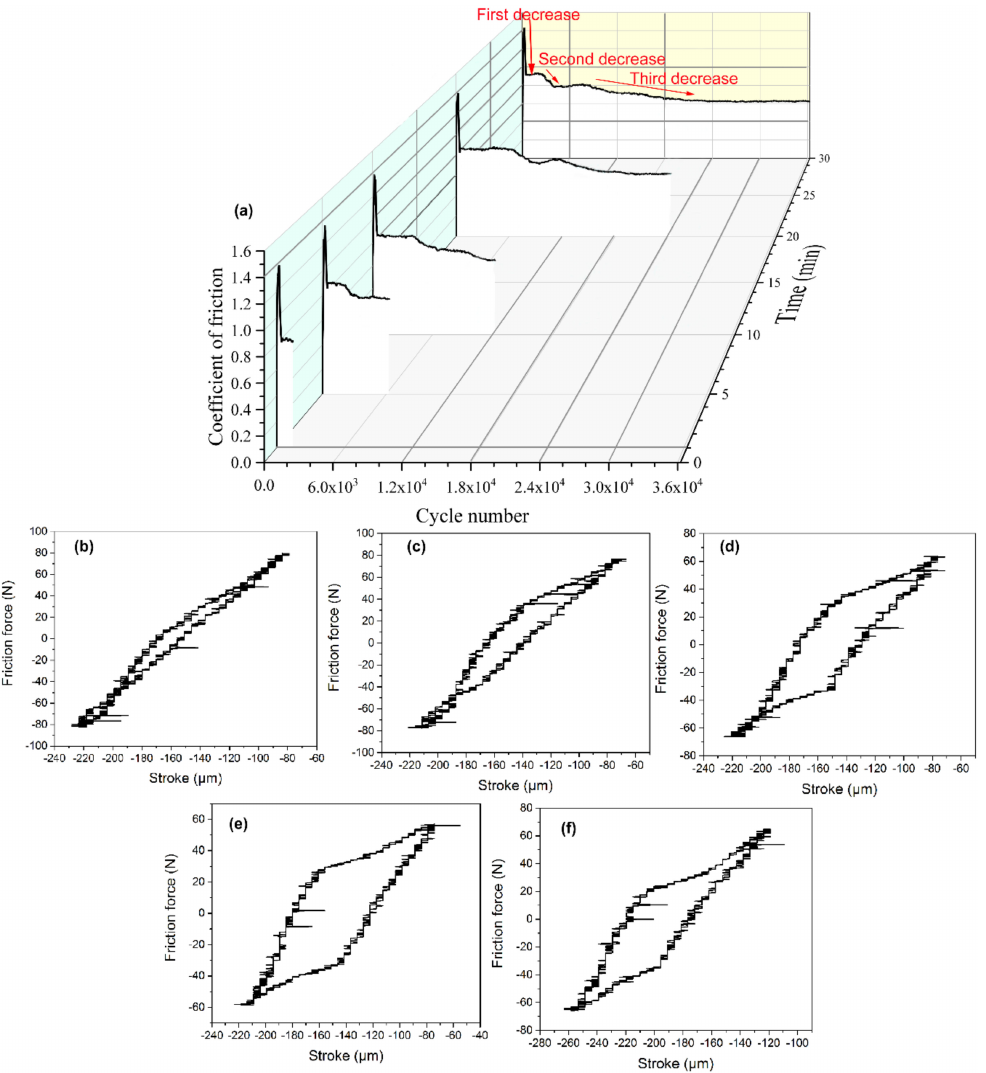
Figure 2. ( a ) The change in the COF as a function of cycle number with the typical Ft–D curves at a cycle number of ( b ) 1.2 × 10 3 , ( c ) 6 × 10 3 , ( d ) 1.2 × 10 4 , ( e ) 2.4 × 10 4 , and ( f ) 3.6 × 10 4 .